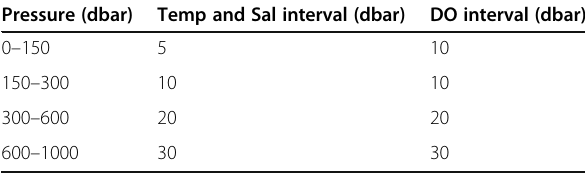
Table 1 Vertical sampling level of the Seaglider Pressure (dbar) Temp and Sal interval (dbar) DO interval